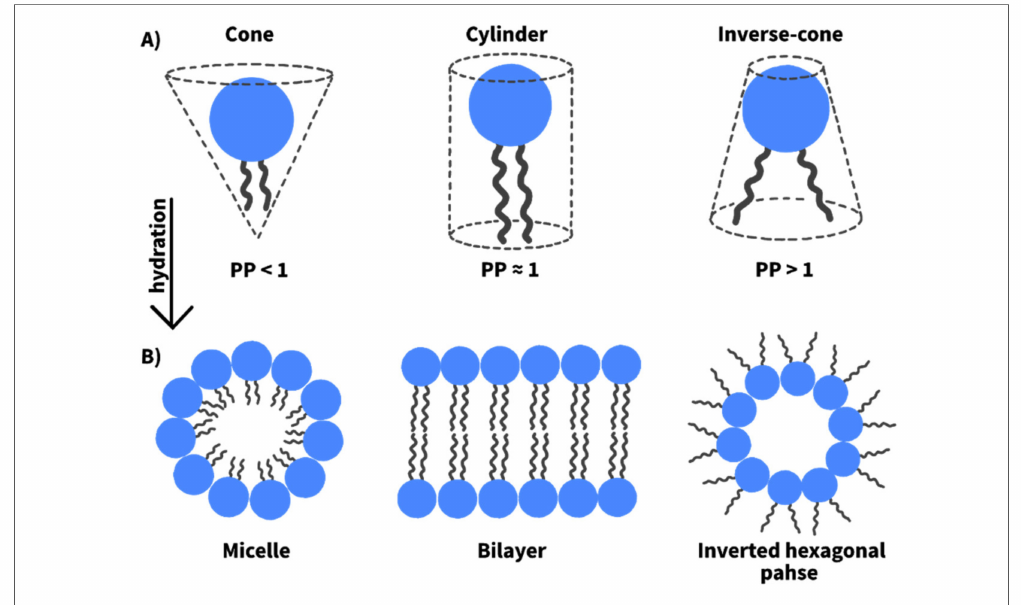
Figure 6. ( A ) Classification of phospholipids based on their geometry and packing parameters; ( B ) phospholipid arrangements when